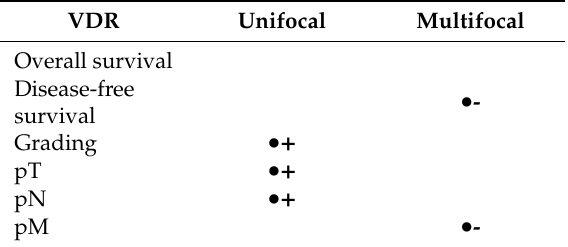
Table 6. Significant results for the vitamin D receptor-positive